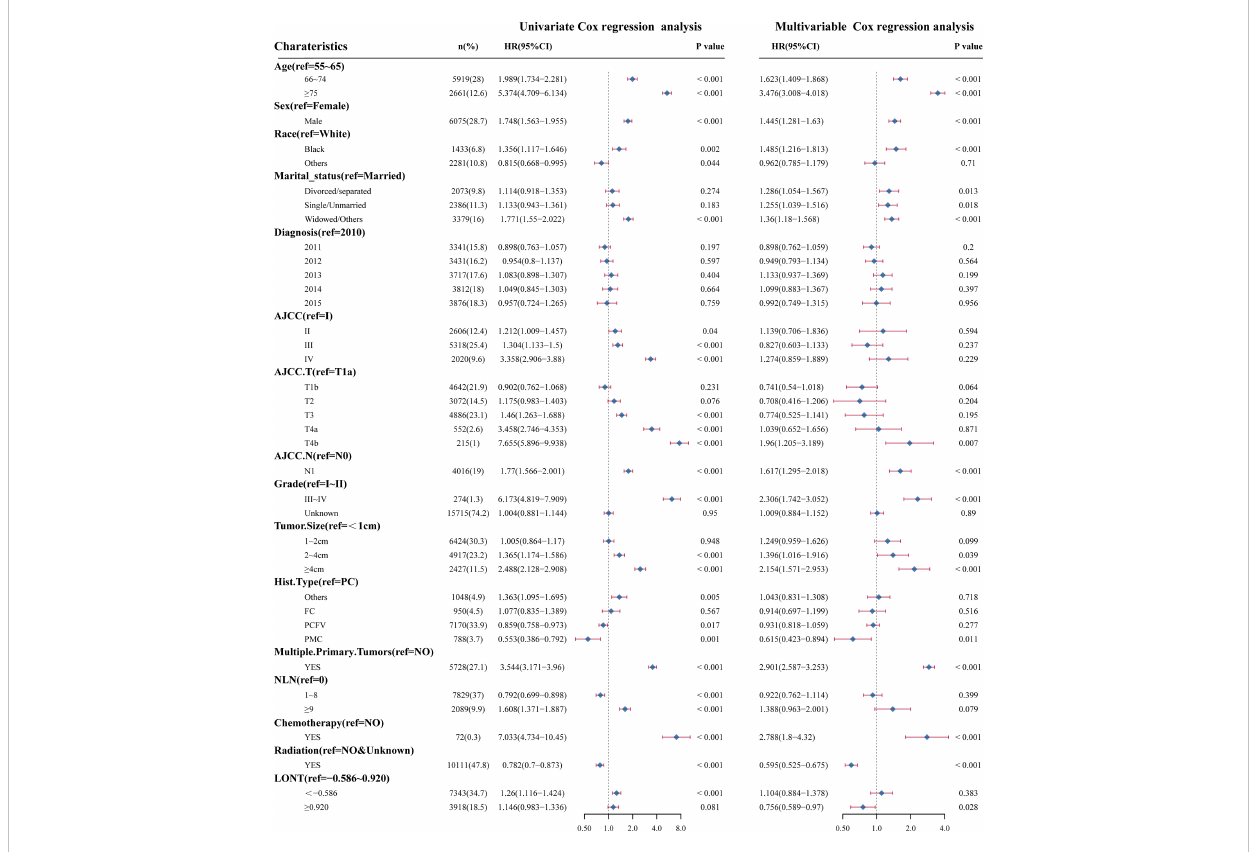
FIGURE 2 Univariate Cox regression analyses and multivariate Cox regression analyses for LONT and clinical features. Forest plot of hazard ratios demonstrating the results of Cox regression analyses. The dashed line denotes where HR = 1.